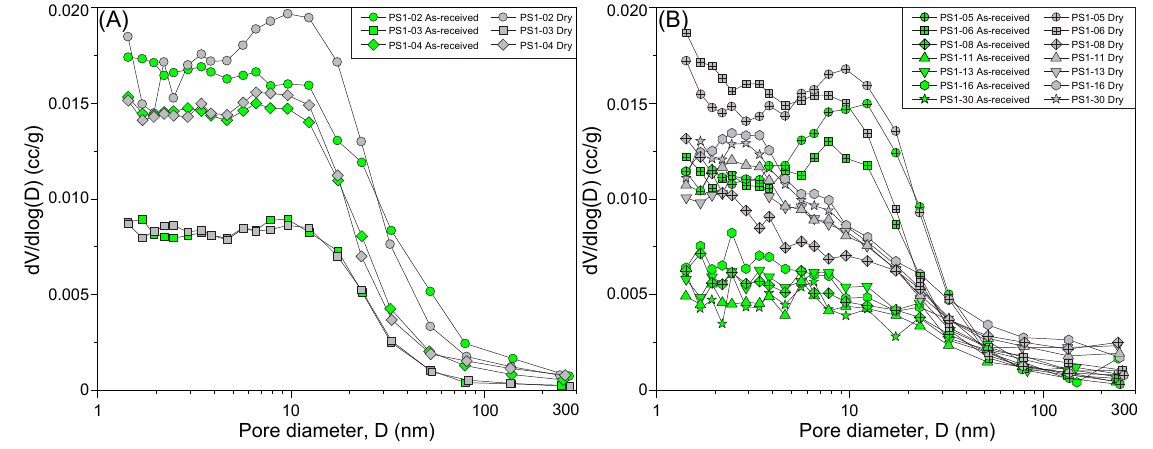
Figure 6. Pore size distribution calculated from the N 2 adsorption isotherms of the as-received and dry shale samples from ( A ) the WF and ( B ) the LMX of the Well PS1.